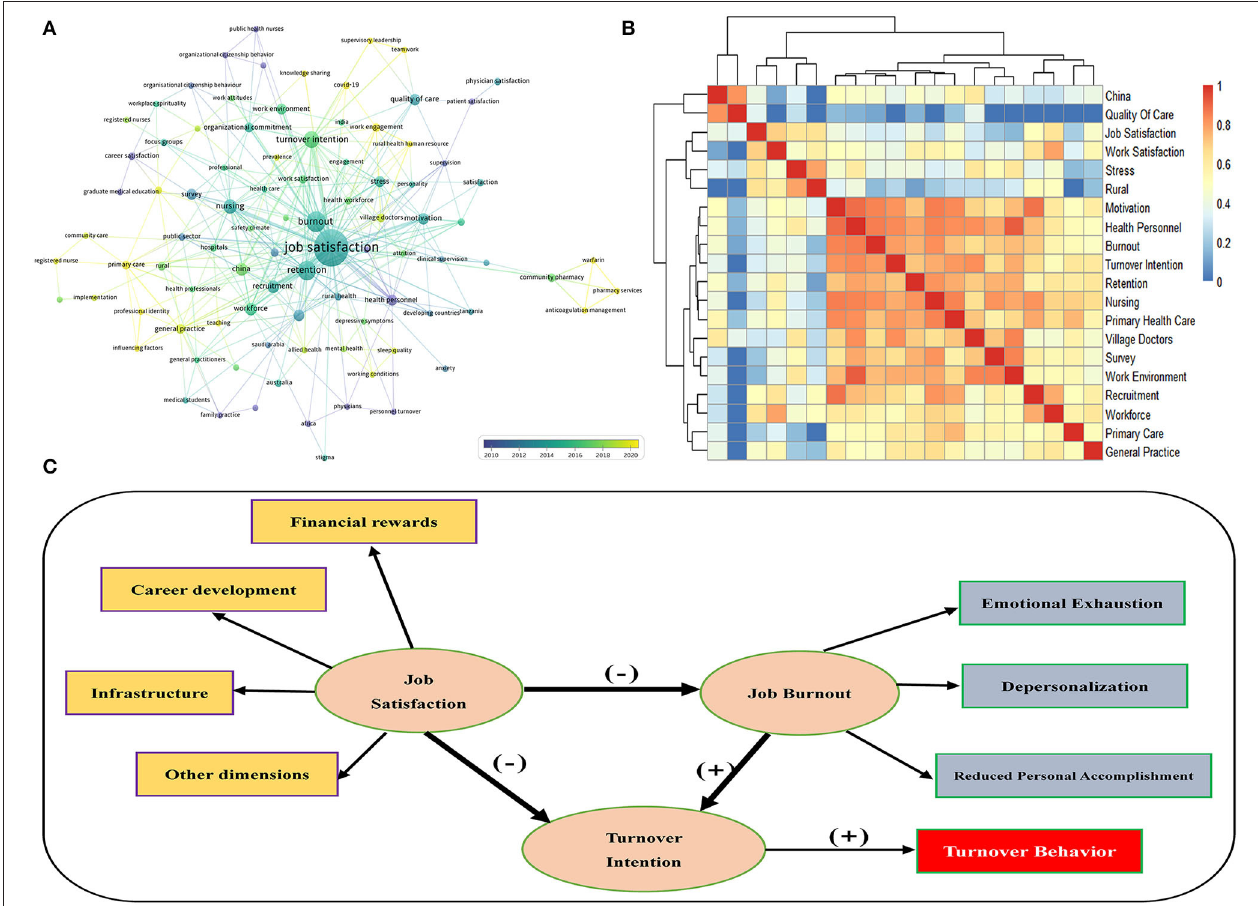
FIGURE 6 | The co-occurrence map (A) , heat map (B) , and relationship (C) of high-frequency